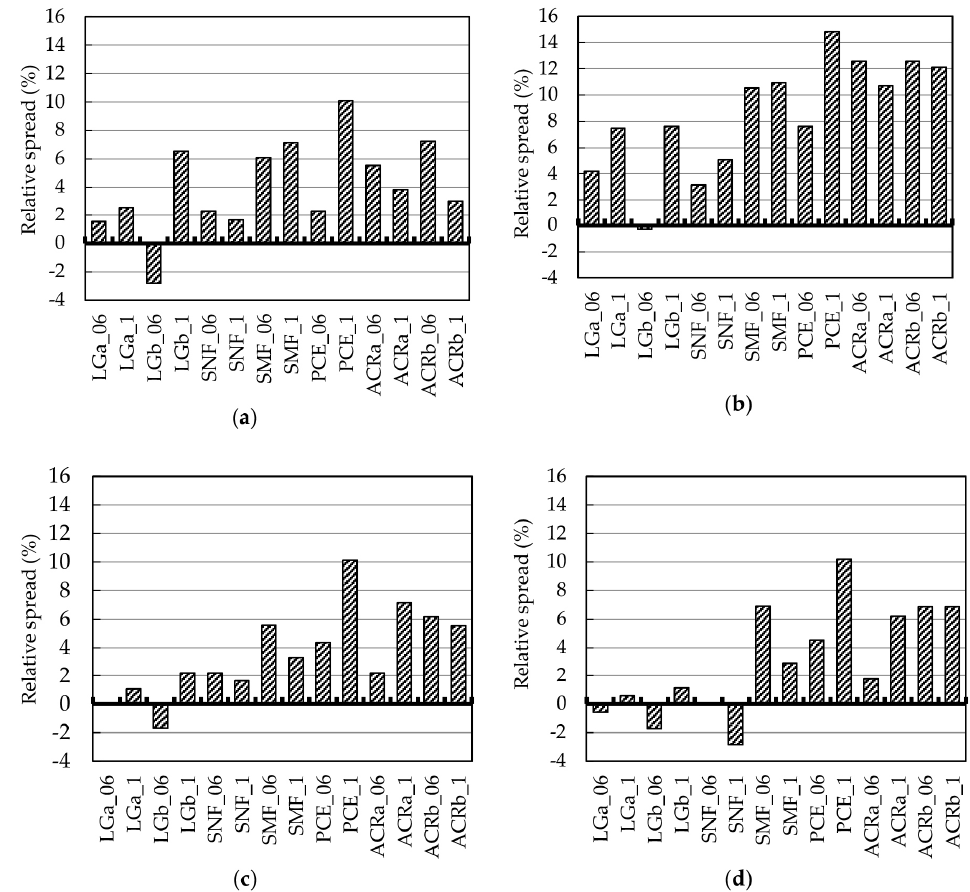
Figure 1. Workability of geopolymer expressed as relative spread (increase or decrease in %) of the geopolymer mixtures immediately ( a ) after mixing; ( b ) after 5 min; ( c ) 15 min; and ( d ) 30 min.